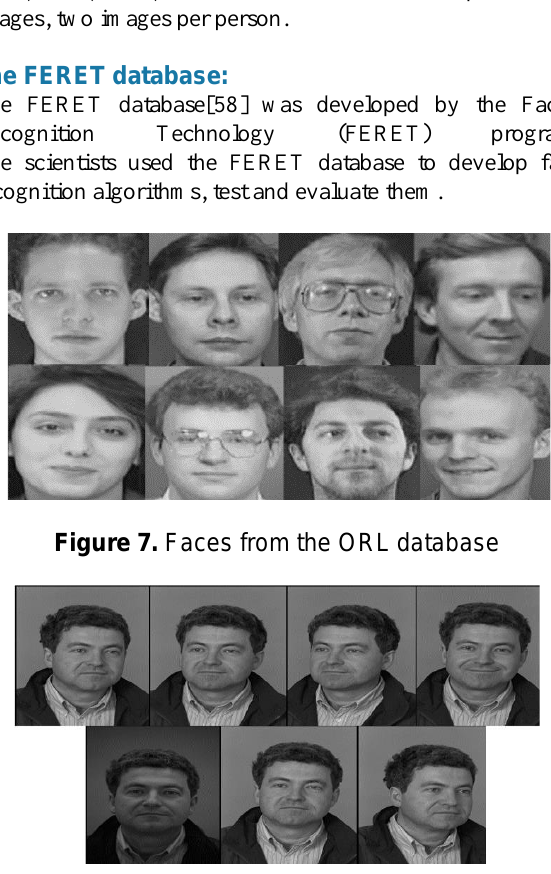
Figure 8. Faces from the FERET database In our experiments, we gathered a subset that contains 1400 images of 200 individuals. Each individual has seven face images of different poses whose names are marked with two characters: “ba”, “bd”, “be”, “bf”, ”bg”, “bj” and “bk” to indicate different face poses. Figure 8 depicts images of a person in this subset. There are variations of illumination, facial expression, and pose in this subset. The images of this subset are divided into five sets (Sub1, Sub2, Sub3, Sub4, and